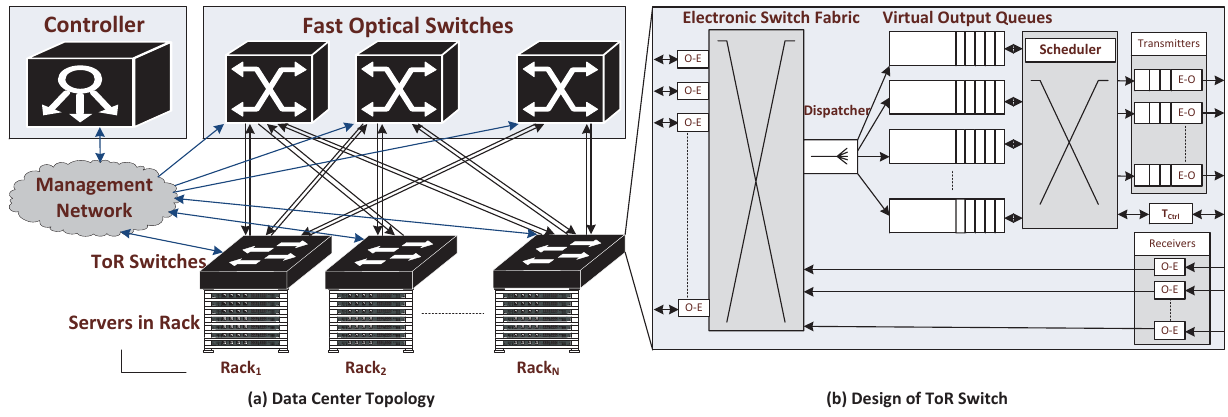
Figure 1. ( a ) Topology Diagram for Data Center Network and ( b ) Design of ToR